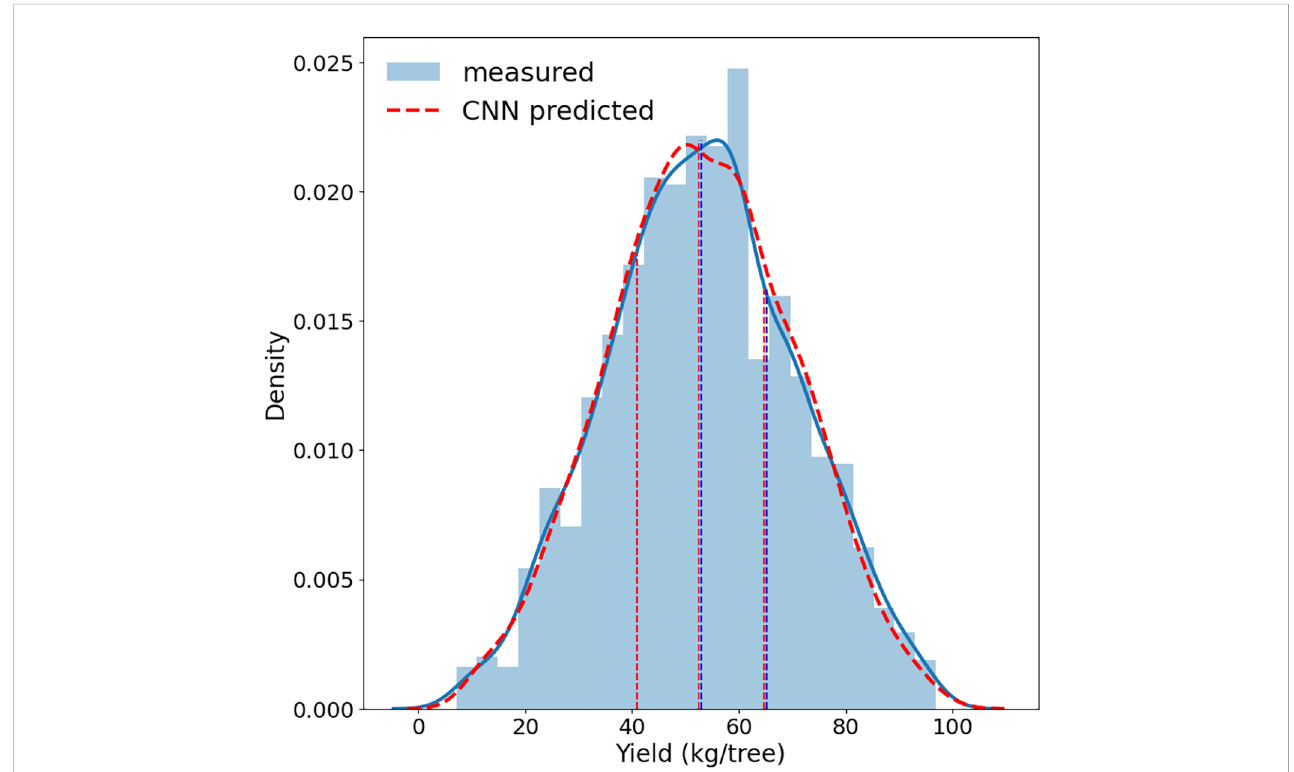
FIGURE 5 Distributions of almond tree yield predicted by the full CNN model (red) vs. measured by individual tree harvester (blue). Dashed vertical lines represents the 25th percentile, median, and 75th percentile